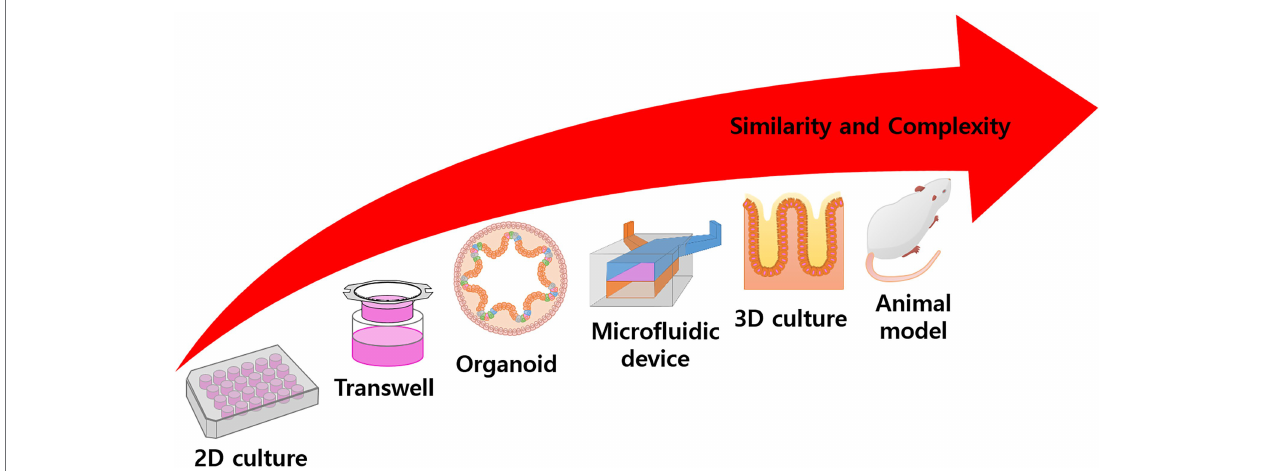
FIGURE 1 | Overall scheme of experimental model. Conventional 2D culturing is rather simple and has high productivity, but application is limited to target treatment experiments. In the Transwell system, the culture area is floated into the media and can simulate mass transfer or other activities. Many models try to simulate specific functions or structures using complex techniques, such as organoid differentiation, microfluidic devices, 3D scaffold fabrication, tissue engineering, etc. In animal models, the body represents a complete model, but there are problems with observation and ethical issues. In general, with increased complexity, the similarity of the model also